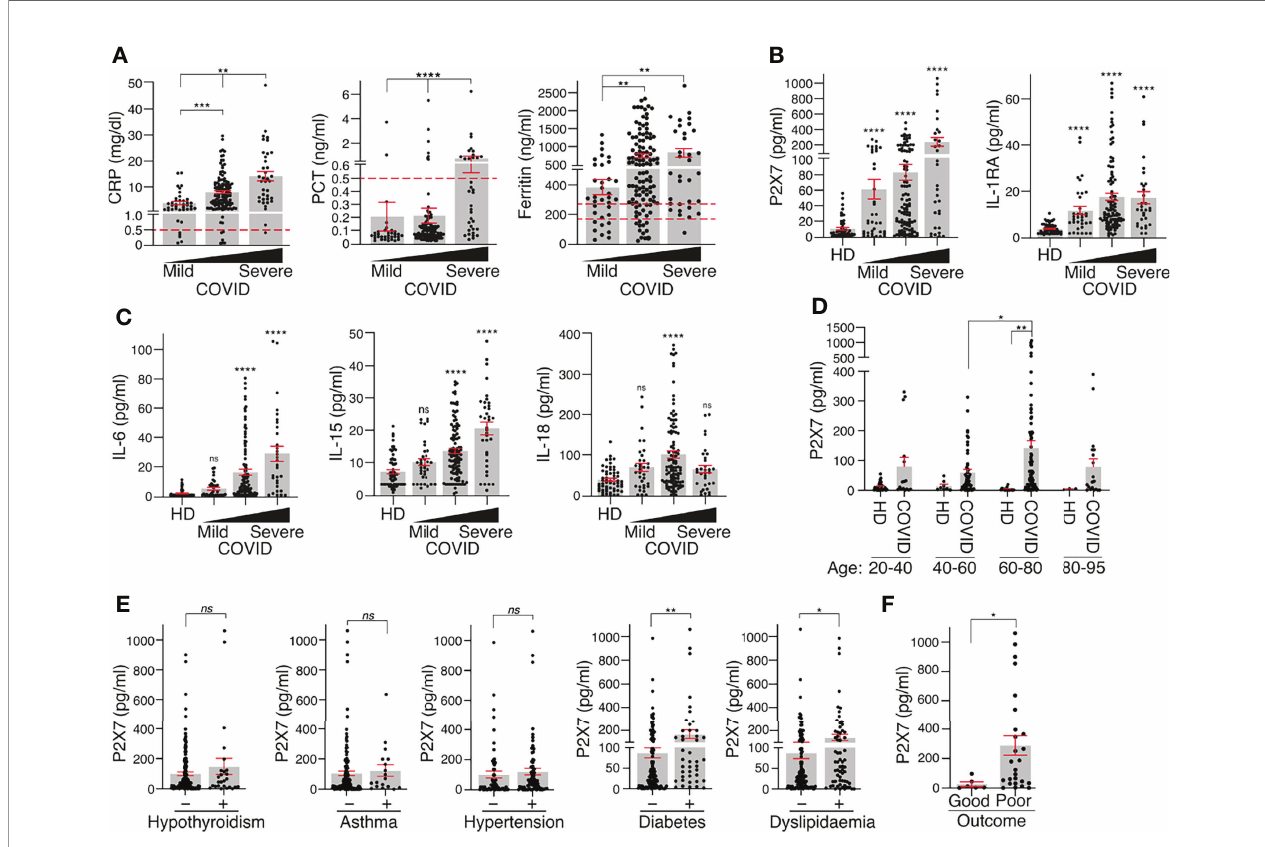
FIGURE 2 | P2X7 receptor and IL-1RA increase with COVID-19 disease severity. (A) Plasma concentration of C-reactive protein (CRP), procalcitonin (PCT) and ferritin in association with the severity of COVID-19 manifestation (mild, moderate or severe). (B, C) Concentration of P2X7 receptor, IL-1RA (B) , IL-6, IL-15 and IL-18 (C) in plasma of healthy donors (HD) and COVID-19 patients in association with the severity of disease manifestation (mild, moderate or severe). (D) Concentration of P2X7 receptor in the plasma of HD and COVID-19 patients in different age groups. (E) Concentration of P2X7 receptor in the plasma of COVID-19 patients with hypothyroidism, asthma, hypertension, diabetes or dyslipidaemia. (F) Concentration of P2X7 receptor in the plasma of severe COVID-19 patients with good or poor outcome (death or prolonged intensive care unit stay). Each dot represents an individual patient; data are represented as mean (grey bars) ± sem; dotted lines represent the normal range for each parameter analysed (the upper line in the Ferritin graph corresponds to normal range for healthy men, and the bottom line corresponds to normal range for healthy women); * p < 0.05; ** p < 0.005; *** p < 0.0005; **** p < 0.0001; ns , no signi fi cant difference ( p > 0.05) with the Kruskal – Wallis test for (A – D) and Mann – Whitney test for (E, D)